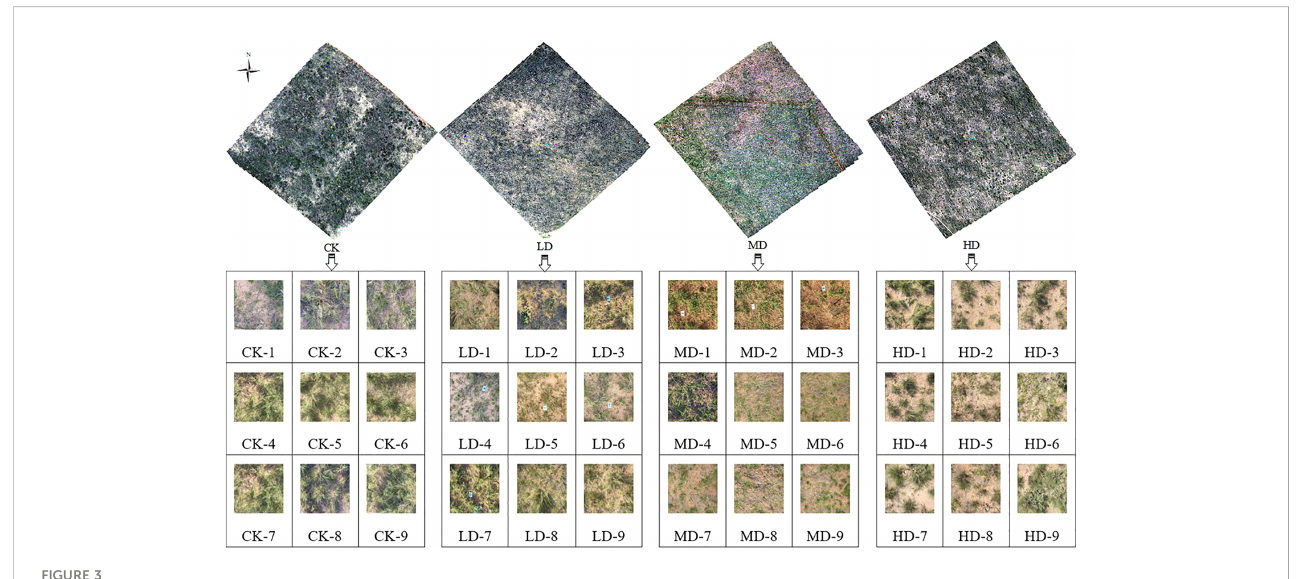
FIGURE 3 Test area and sample